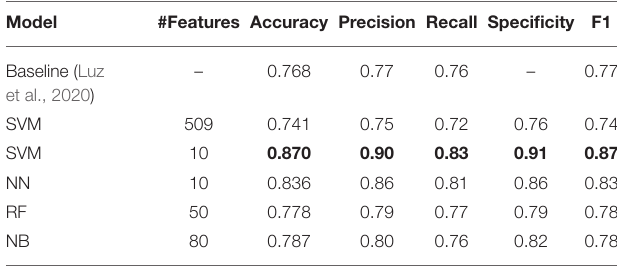
TABLE 11 | LOSO-CV results averaged across three runs with different random seeds on the ADReSS train set.